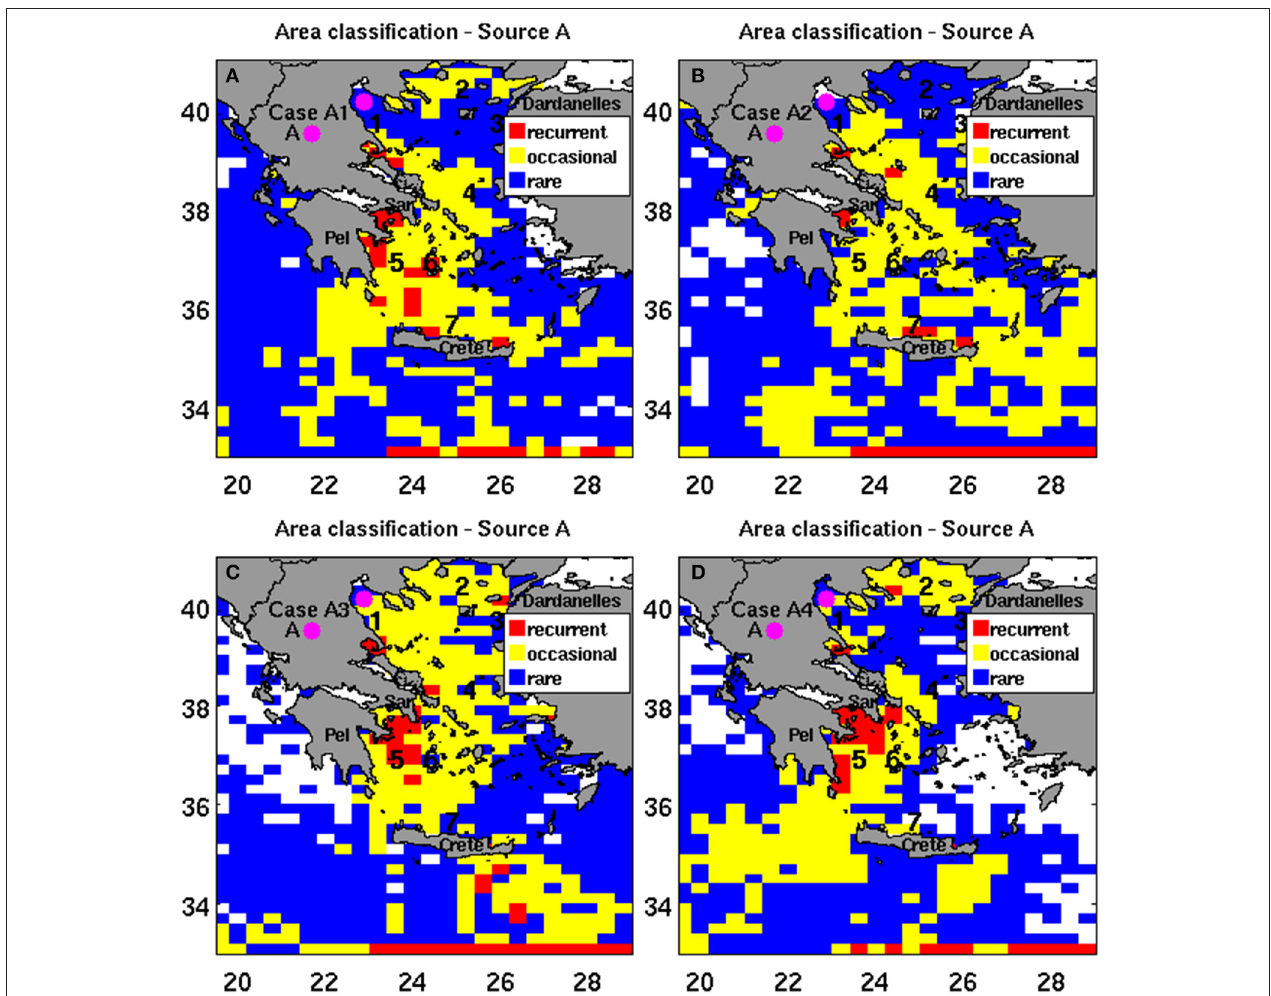
FIGURE 6 | Area classification maps of floating litter particles originated from Source region A (Thermaikos Gulf) in Cases (A) A1, (B) A2, (C) A3, and (D) A4. Magenta dot point indicates the source region A.